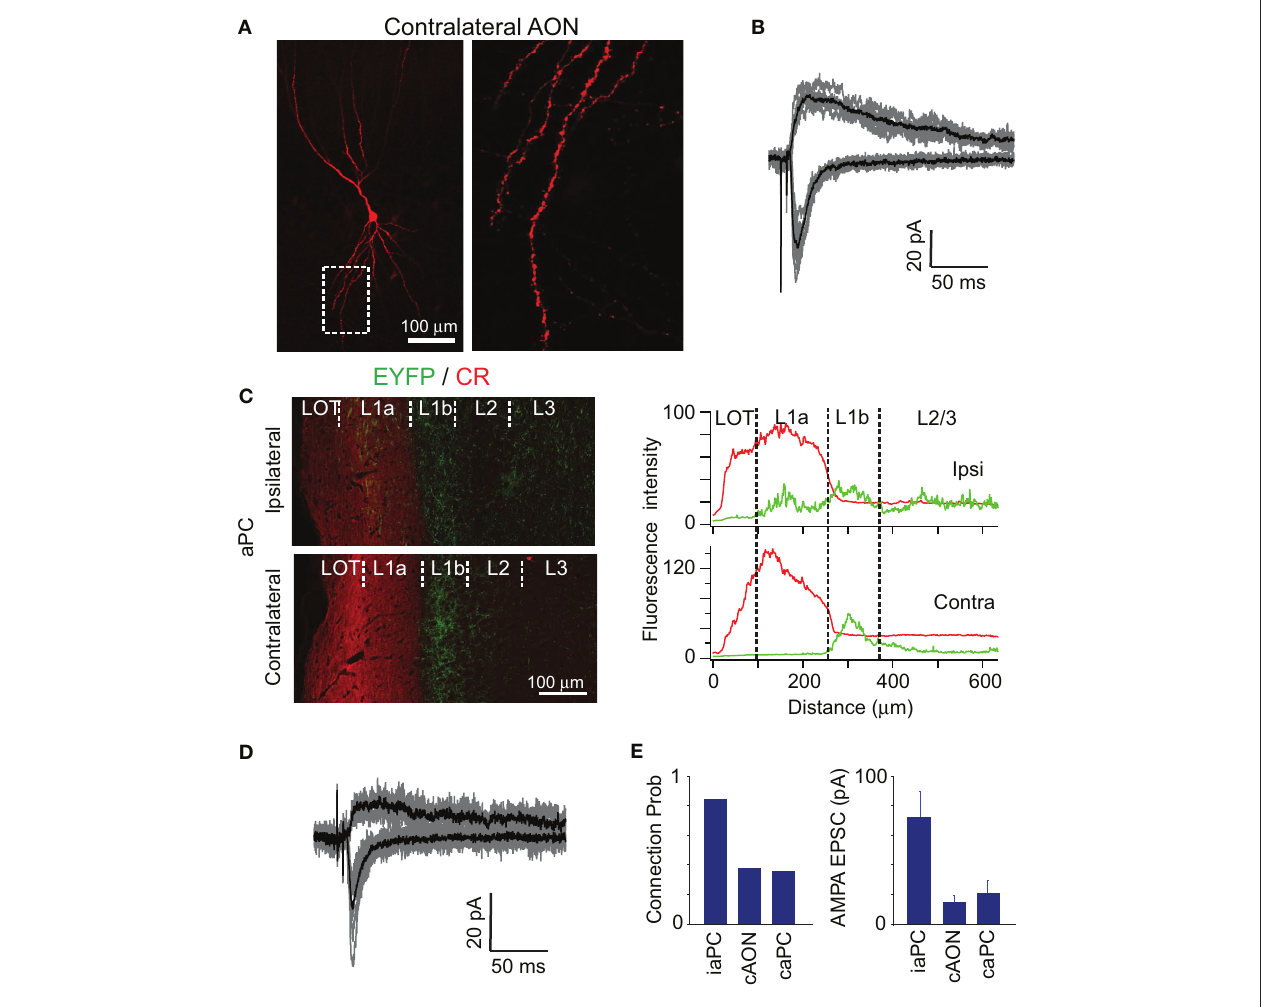
FIGURE 5 | Contralateral projection from AON. (A,B) ChR2-EYFP signal was readily observed in the contralateral AON. Light-evoked synaptic currents were recorded in the contralateral AON neuron (B) , but the probability of finding a connection was only 0.38. (C) Axonal projections to the ipsi- and contralateral aPC from AON revealed by injection of AAV into an adult mouse. Sections were stained with anti-calretinin (CR) antibodies (red), a marker of mitral cell axons and some inhibitory neurons within the PC. CR staining allowed us to visualize the border between layer 1a and layer 1b. In